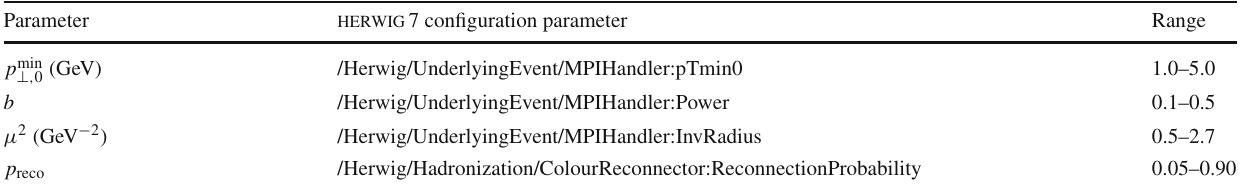
Table 1 Parameters considered in the tuning, and their allowed ranges in the fit Parameter herwig 7 configuration parameter